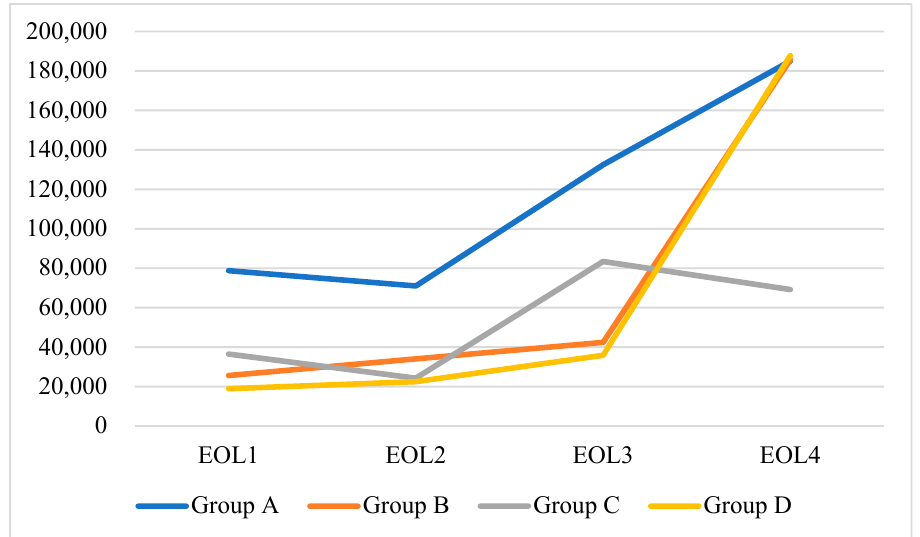
Figure 2. Medical cost in every quarter in the year before death in COPD patients using the 2011 COPD staging edition.